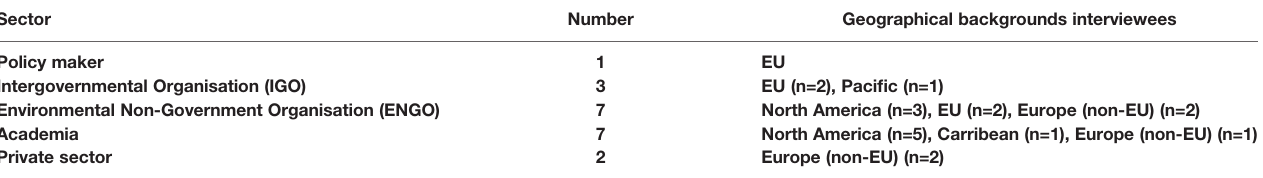
TABLE 1 | Number of interviewees and their backgrounds.